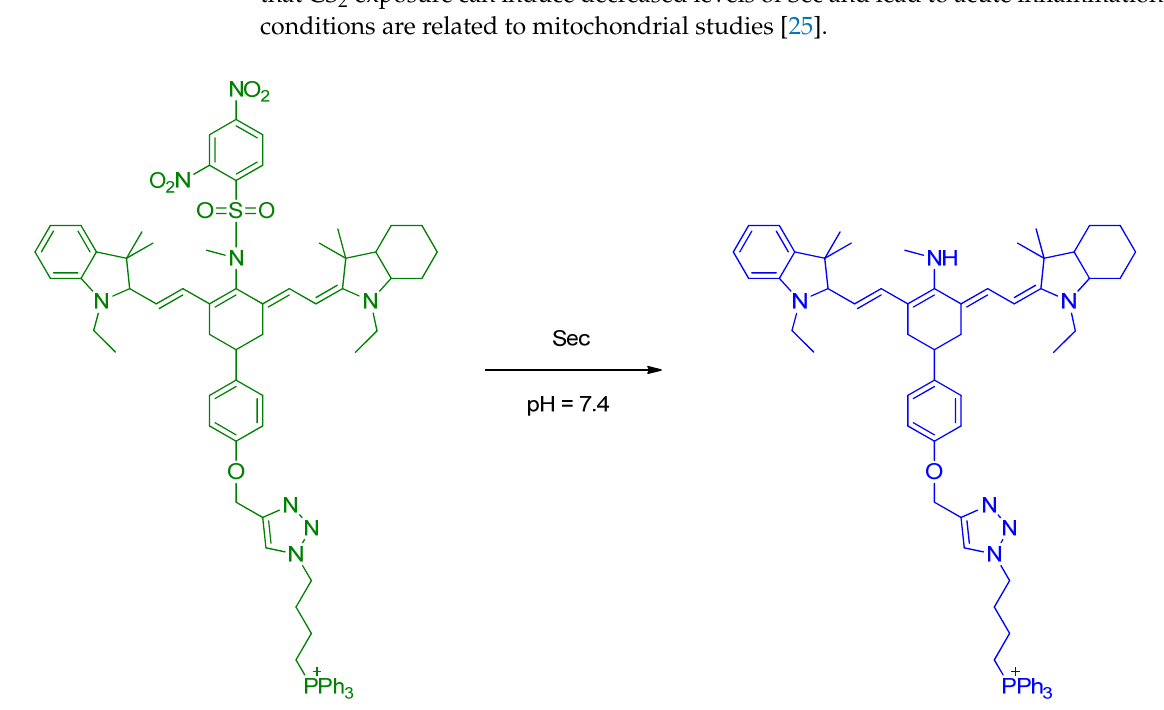
Figure 3. Detection mechanism of Mito– di NO 2 for Sec by Han et al.